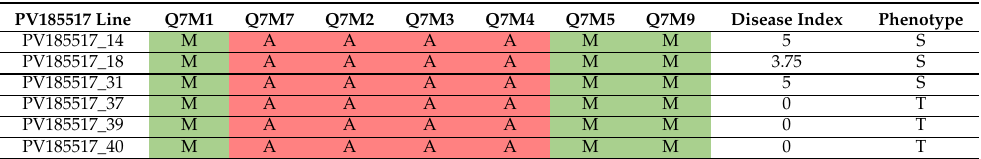
Table 3. CAPS markers analysis of the QTL on chromosome 7 in line PV185517. In the table, a number of plants with segregating phenotypes is given. A = homozygous for S. arcanum LA2157 allele, M = homozygous for S. lycopersicum cv. MM, S = susceptible, T = tolerant.